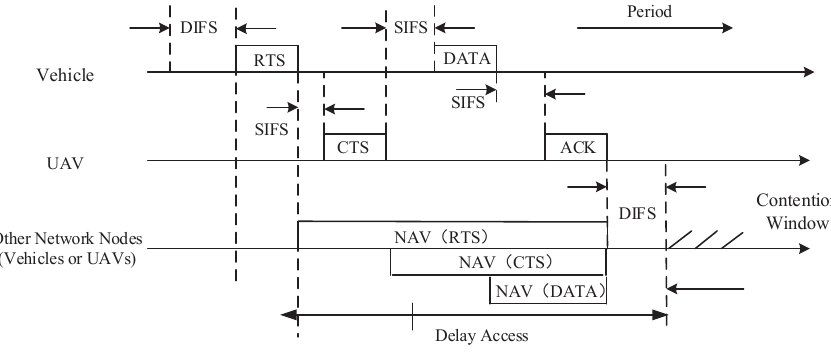
Figure 3. Request to send/clear to send (RTS/CTS)